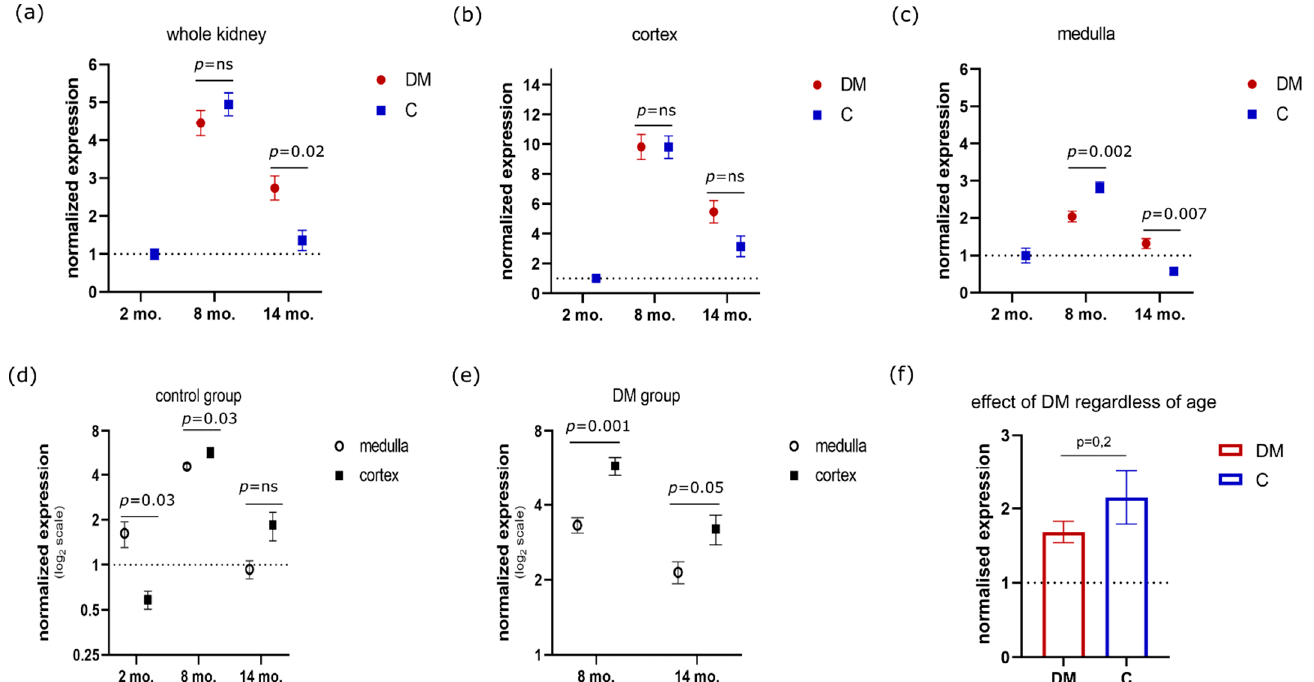
Figure 2. Normalized expression levels of MSH2 in whole kidney ( a ), cortex ( b ) and medulla ( c ) along with the direct comparison of expression levels between medulla and cortex in control ( d ) and diabetic groups ( e ). The last chart ( f ) represents a comparison of MHS2 expression in diabetic and healthy rats (C) regardless of age and tissue compartment. In each chart, expression was normalized to the level of a 2-month-old group, data are shown as the mean and standard error of mean. Rats in diabetes mellitus group (DM) were diabetic for 6 months in the case of the 8-month-old group and 12 months in the case of the 14-month-old group. All p -values presented in the figure were calculated by a t -test.